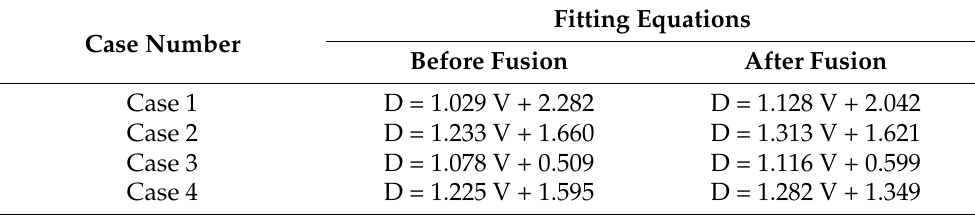
Table 5. Fitting equation of lateral displacement and wind speed in the mid-span of the bridge before and after the fusion. Case